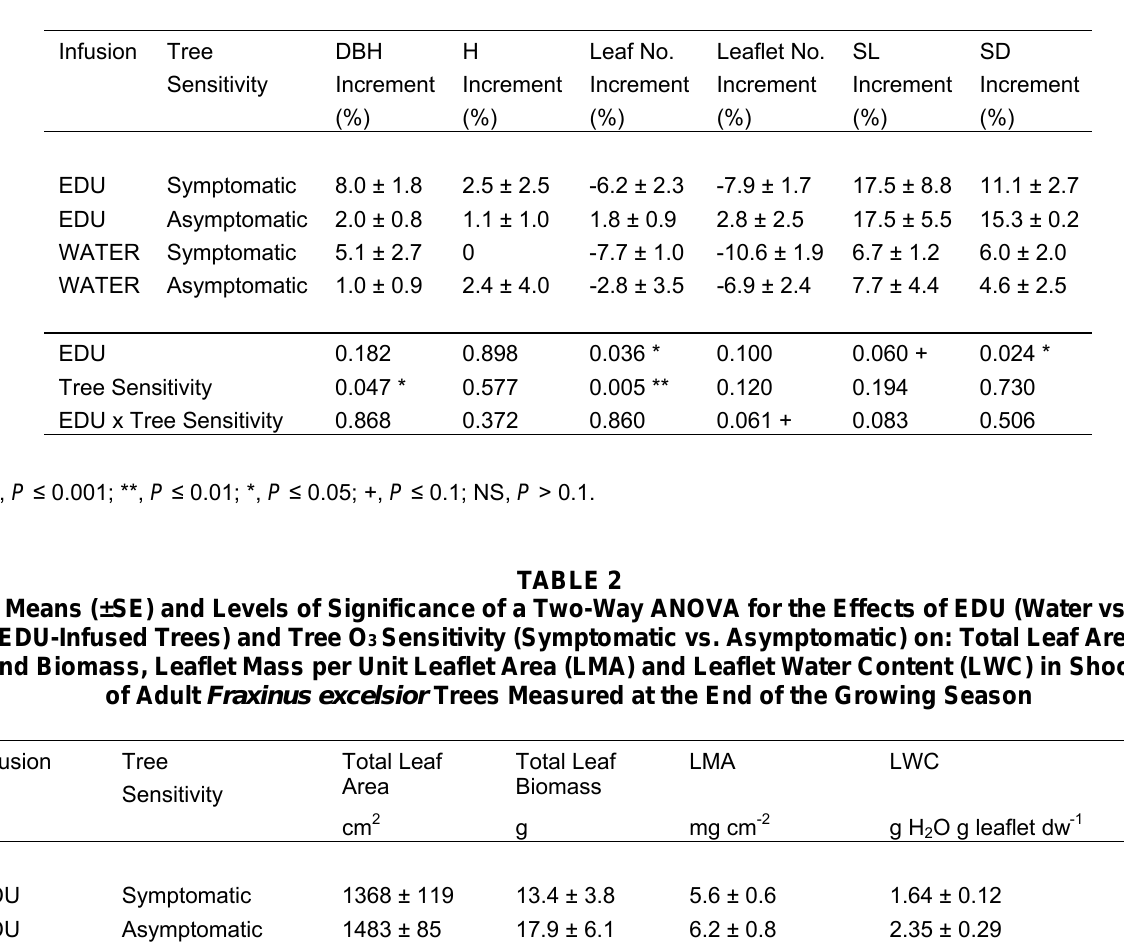
Means (±SE) and Levels of Significance of a Two-Way ANOVA for the Effects of EDU (Water vs. EDU-Infused Trees) and Tree O 3 Sensitivity (Symptomatic vs. Asymptomatic) on the Increments (September vs. May) in: Diameter at Breast Height (DBH), Tree Height (H), Leaf Number per Shoot (Leaf No.), Leaflet Number per Shoot (Leaflet No.), Shoot Length (SL), and Shoot Diameter (SD), in